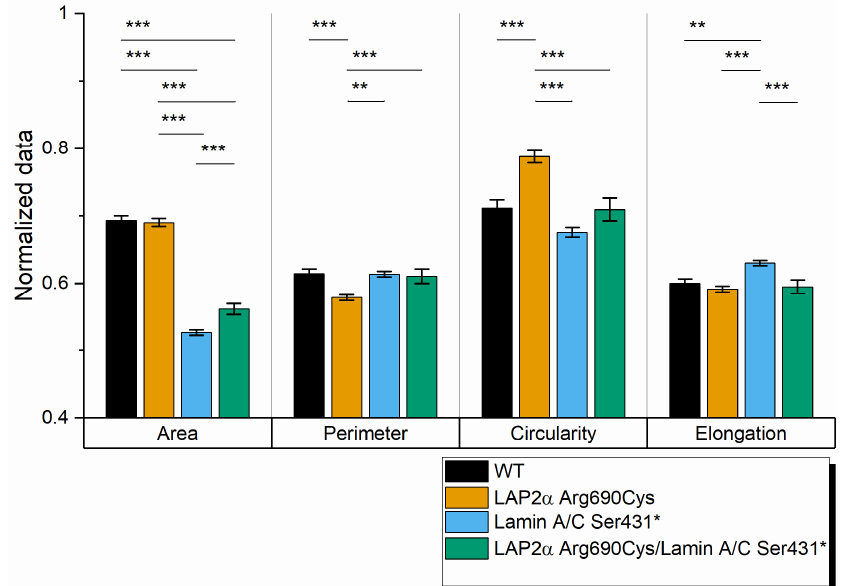
Figure 6. Comparison of shape descriptors for leukocyte nuclei from family members with different Lap2 α Arg690Cys and Lamin AC Ser431* variant combinations. Bar graphs report the mean ± SEM values of each descriptor. Differences between genotypes were tested with one-way ANOVA and post hoc Tukey’s mean comparisons. * p < 0.05; ** p < 0.01, *** p < 0.001. LAP2 α , Lamin AC, and DNA fluorescence signals were then measured through Int. J. Mol. Sci. 2022 , 23 , x FOR PEER REVIEW nuclei cross-sections, attempting to obtain a more objective measure of nuclear LAP2 α and Lamin AC fluorescence distribution (Figure 7). LAP2 α mean peak fluorescence was significantly higher in LAP2 α Arg690Cys heterozygous, Lamin AC Ser431* heterozygous, and double heterozygous nuclei compared to wild-type nuclei ( p < 0.01, p < 0.05 and p < 0.05, respectively). Moreover, lamin AC mean peak fluorescence was higher in Lamin AC Ser431* heterozygous and double heterozygous nuclei as compared to wild-type nuclei ( p < 0.001 and p < 0.05, respectively). Mean ToPro fluorescence peaks did not differ among the different genotypes.